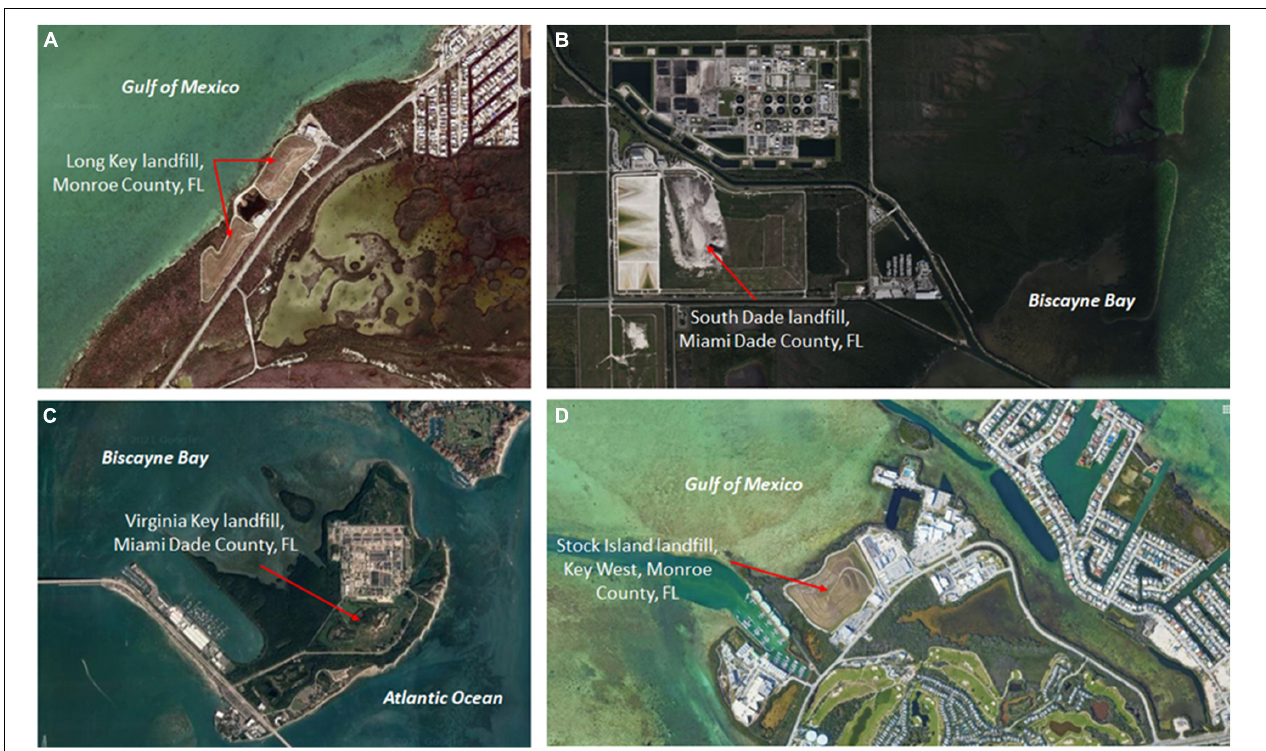
FIGURE 9 | Aerial photos of (A) the Long Key landfill in Monroe County, FL, next to the Gulf of Mexico, (B) the South Dade landfill in Miami, FL, next to Biscayne Bay, (C) the Virginia Key landfill in Miami Dade County, FL, between Biscayne Bay and the Atlantic Ocean, and (D) the Stock Island landfill in Key West, Monroe County, FL, next to the Gulf of Mexico (source: Google